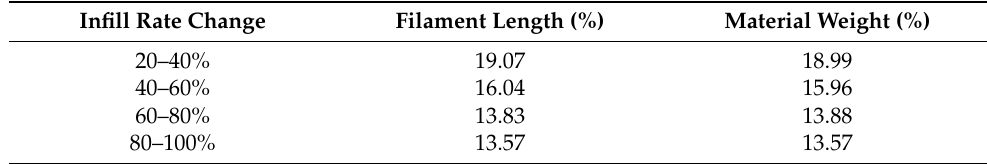
Table 3. Filament length and specimen weight variation with the infill